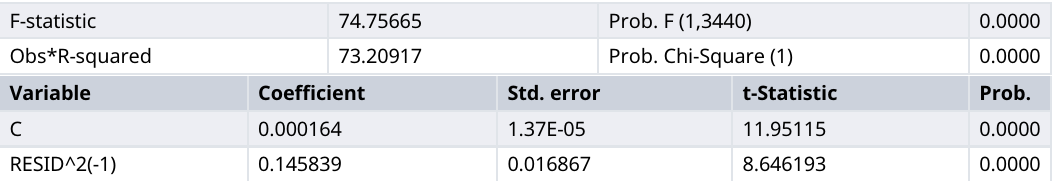
Table 2. Heteroskedasticity Test: ARCH. dependent variable; RESID^2 (method: least squares).